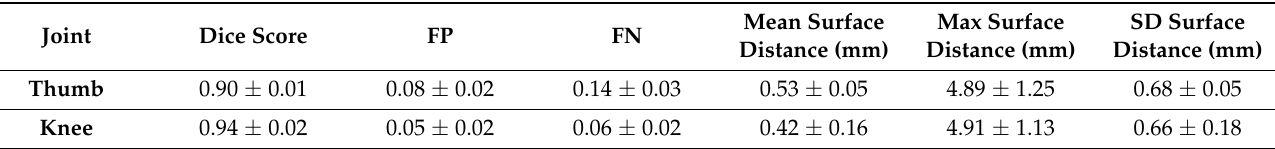
FP = false positive error fraction, FN = false negative error fraction.